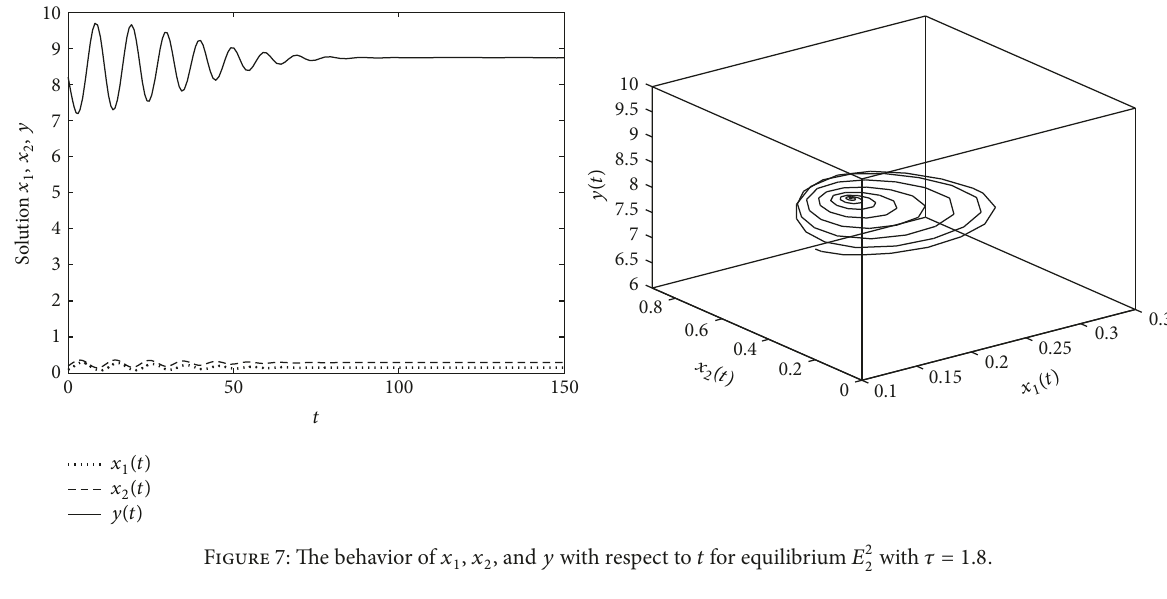
Figure 7: The behavior of 𝑥 1 , 𝑥 2 , and 𝑦 with respect to 𝑡 for equilibrium 𝐸 2 2 with 𝜏 = 1.8 .